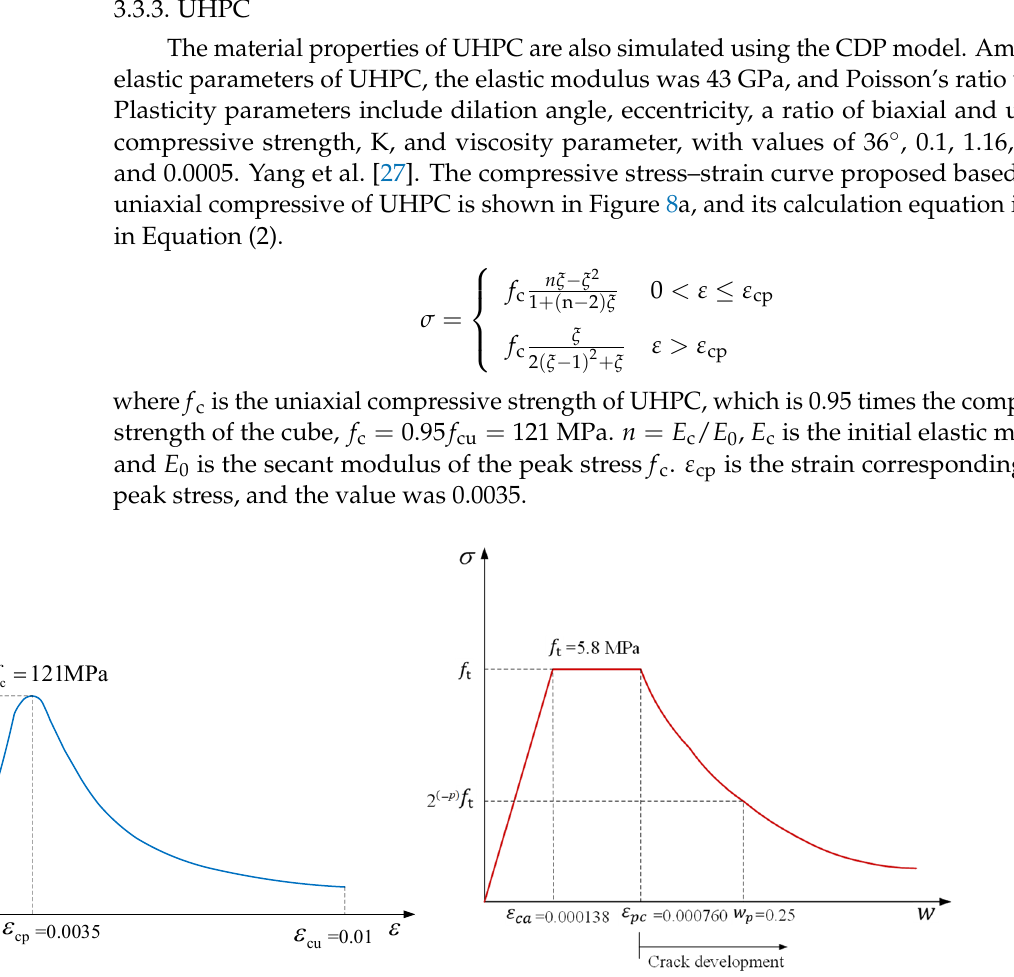
Figure 8. Constitutive relationship of the UHPC: ( a ) compression; ( b ) tension.